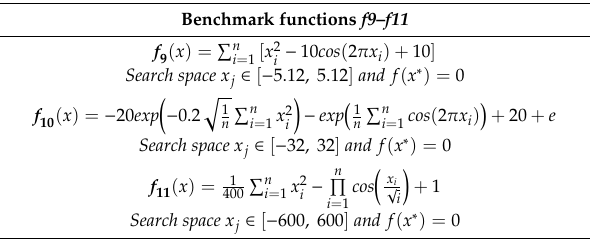
Table 3. Multimodal benchmark functions.